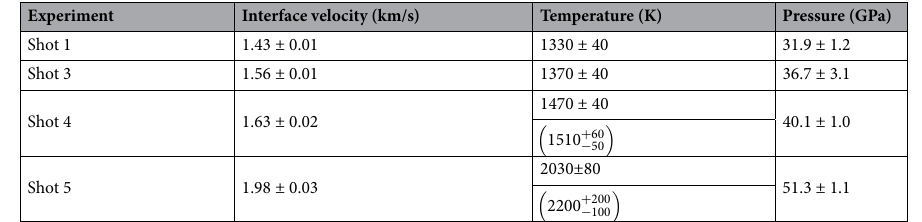
Table 2. Experimentally determined pressure and temperature states of shocked Sm. Values are averaged during the quasi-static period in each case except Shot 5, which was restricted to t < 160 ns. Parenthesis indicate temperatures obtained from the 1125 nm band only; all other temperatures are based on three spectral bands.